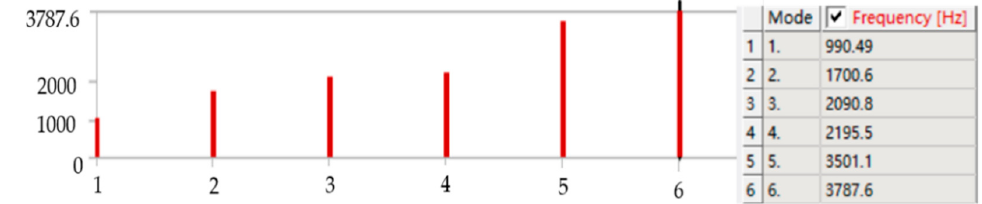
Figure 11. The first six natural frequencies of the micro-drive mechanism.